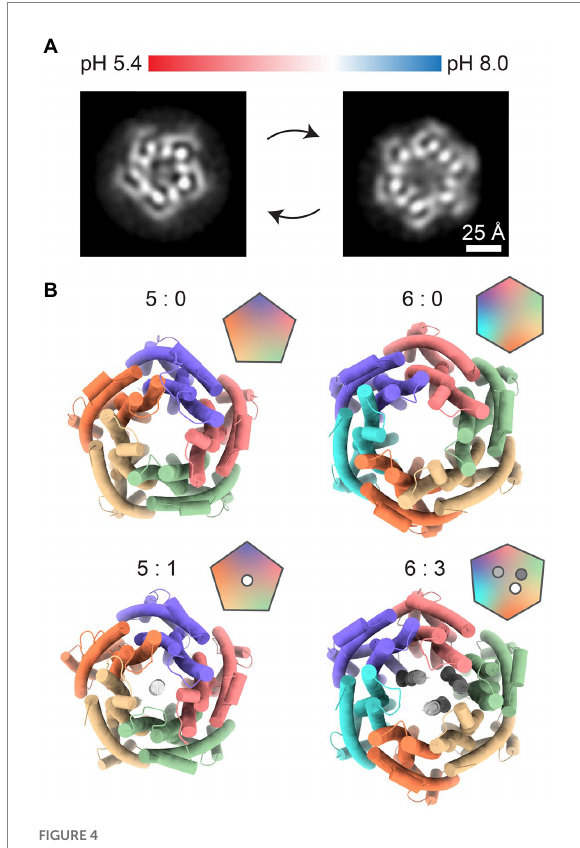
FIGURE 4 Other possible stoichiometries of the ExbB/D complex. (A) Changes in pH shift the equilibrium between pentameric (left) and hexameric (right) ExbB/D complexes. Images represent relevant 2D class averages from Maki-Yonekura et al. (2018). (B) Top views of previously solved ExbB/D complexes. Labels indicate the ExbB:ExbD ratio. The 5:0 complex (PDB ID: 5SV0) was published by Celia et al. (2016). The 5:1 (PDB ID: 5ZFV), 6:0 (PDB ID: 5ZFP) and 6:3 (PDB ID: 5ZFU) complexes were published by Maki-Yonekura et al.